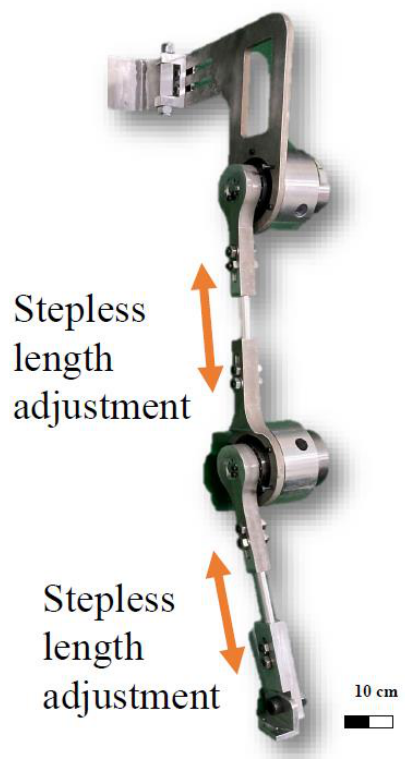
Figure 15. Adjustable length for various heights of wearers.